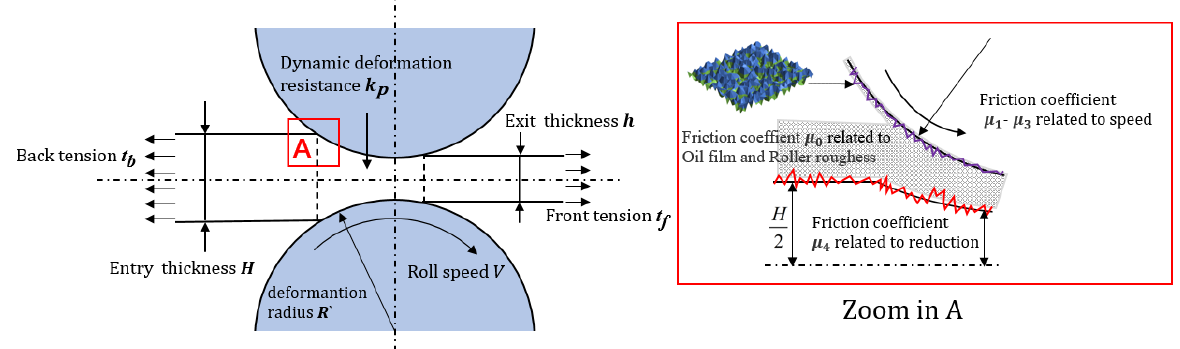
Figure 1. The deformation zone of the roll gap.